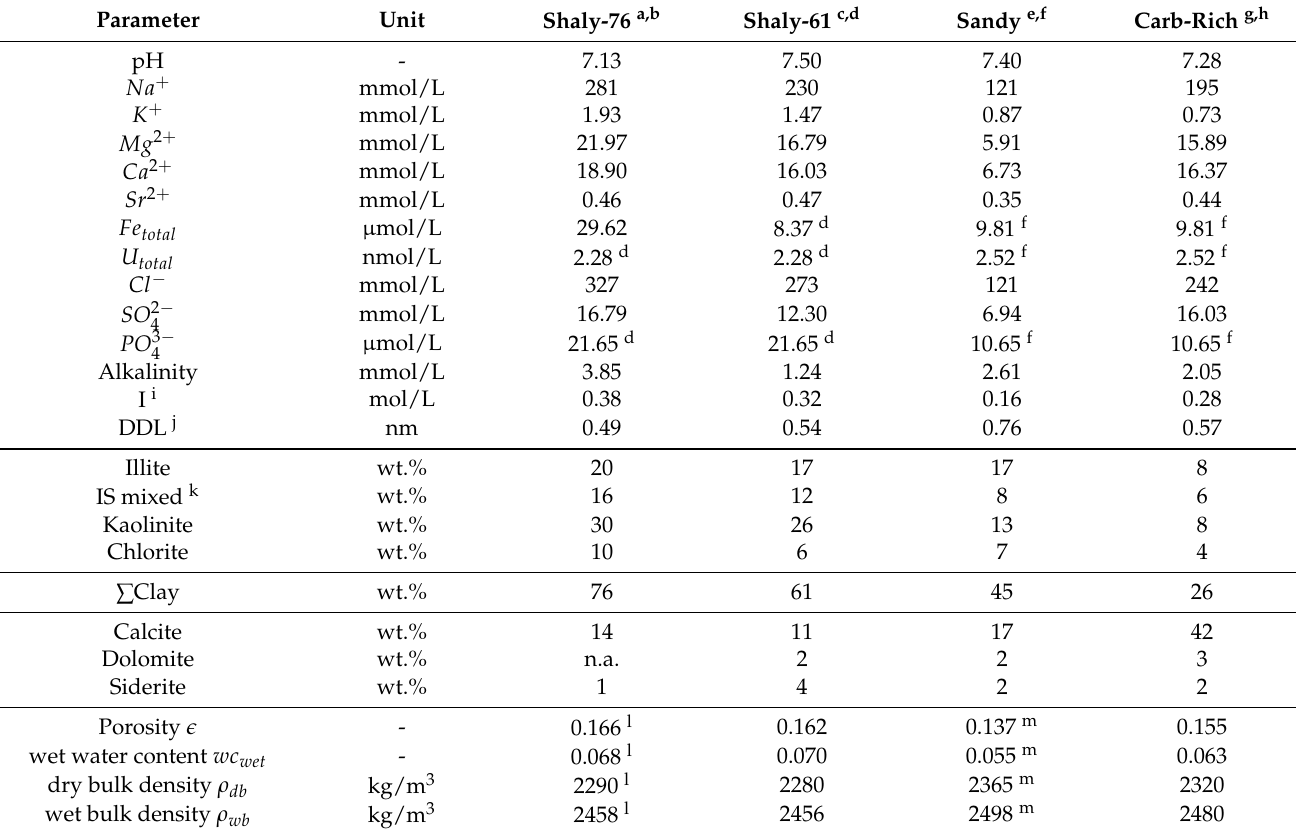
Table 1. Input parameters representing the three facies, shaly, sandy and carbonate-rich. Concentrations are given as average values from the borehole analyses. Shaly-76 and Shaly-61 correspond to the clay mineral content in wt.% at the sampled